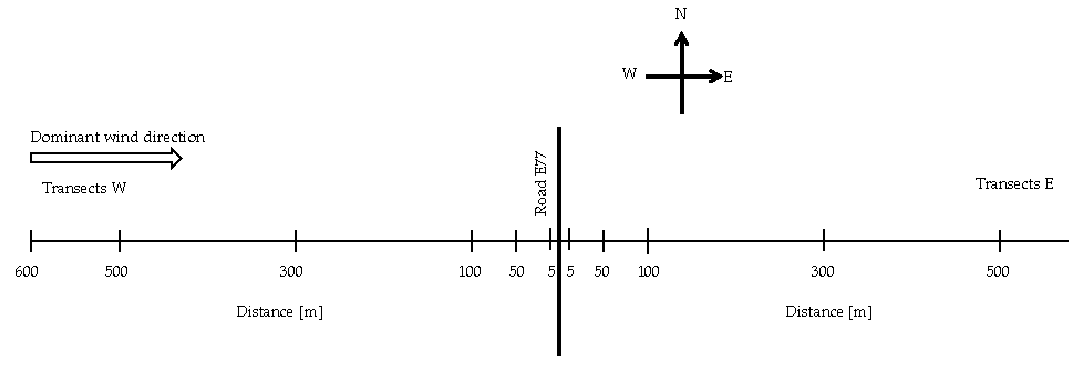
Figure 1. Location of sampling sites.